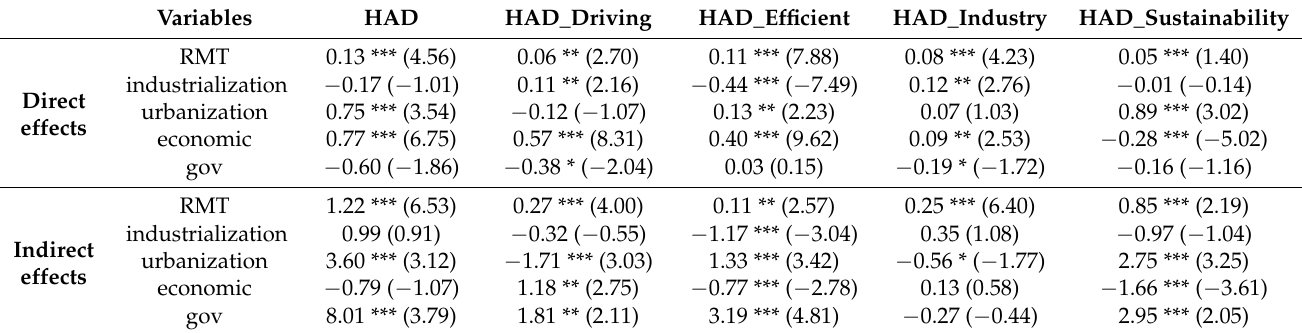
Table 3. Results of direct effects and indirect